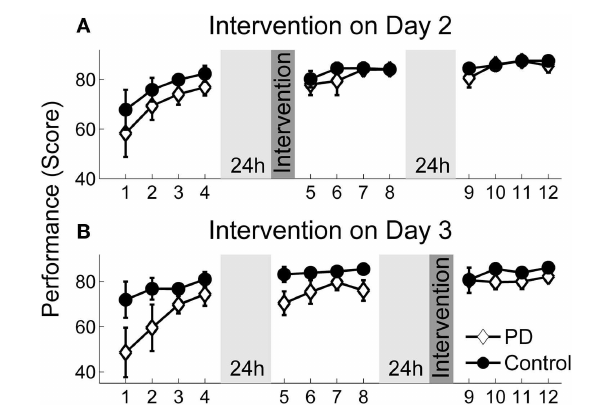
FIGURE 4 | Performance scores over practice. Average performance scores over practice for patients and the control group assigned to their intervention groups. Each session consisted of 4 blocks (50 trials).There were 24h breaks between sessions. (A) Performance change for the group that received intervention on day 2. (B) Performance change for the group that received intervention on day 3. Error bars denote the standard error of the